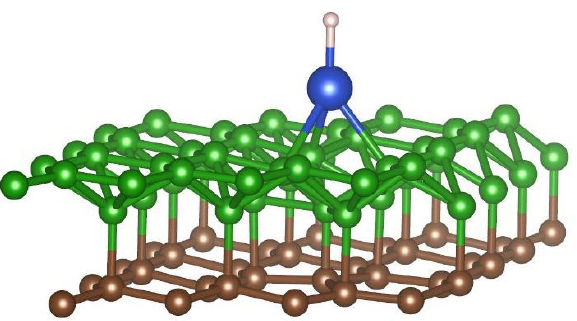
Figure 3. Adsorption of the hydrogen atom on the metal-decorated borophene-graphene structure. Brown, green, blue, and white balls represent carbon, boron, metal, and hydrogen atoms, respectively. Table 2. Adsorption energies E H (see Equation (2)) of the hydrogen atom on the Cu- and